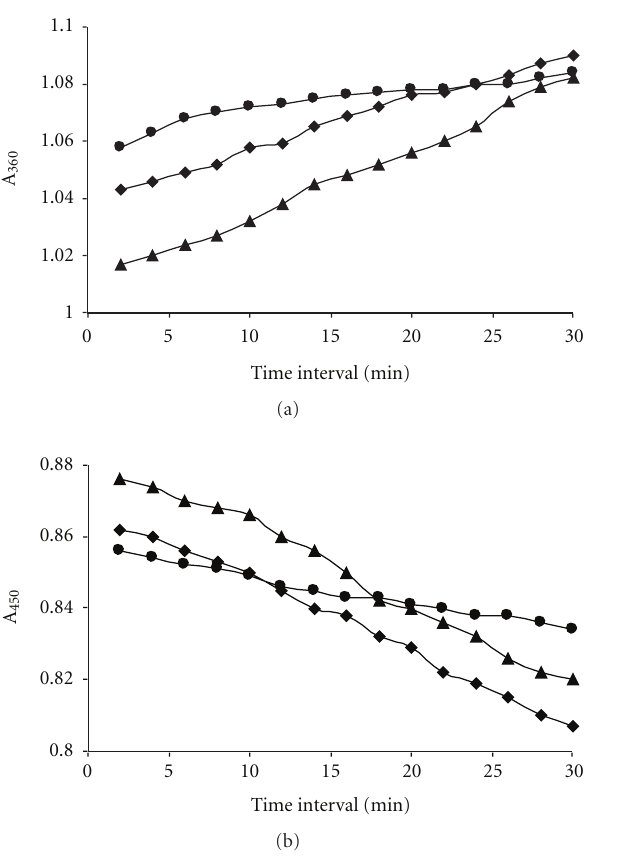
Figure 5: Humic acid depolymerizing activity of the purified enzyme. (a) Increase in absorbance at 360 nm; (b) decrease in absorbance at 460 nm. The reaction solution 1 mL contained “200 μ g of humic acid, 5 μ g of the enzyme (4IU/mg), 40 μ M H 2 O 2 , 100 μ M MnSO 4 in 20mM of bu ff ers pH 4.5.” Sodium succinate bu ff er ( (cid:2) ), sodium lactate bu ff er ( (cid:2) ), and sodium malonate bu ff er ( (cid:3) ).